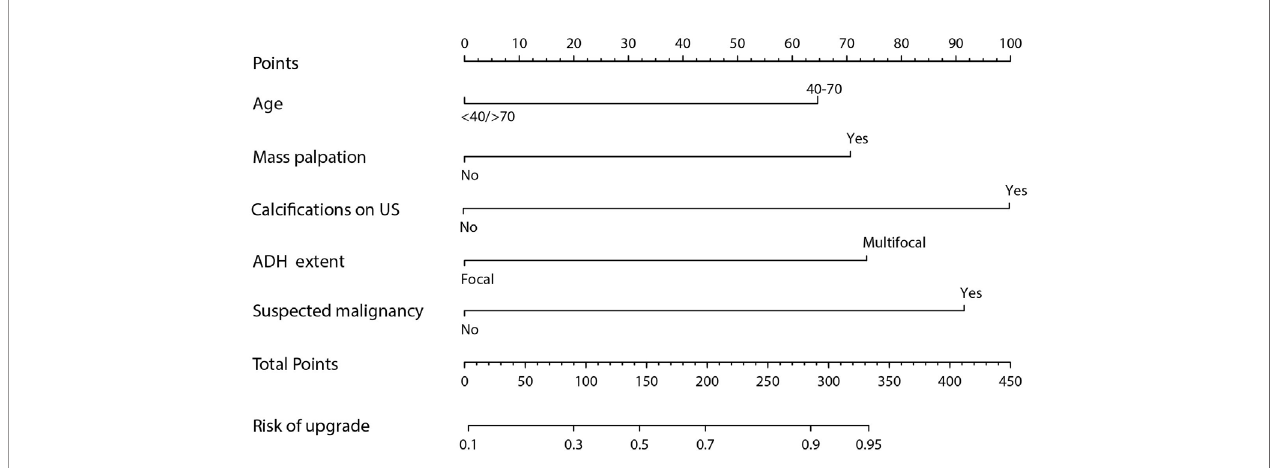
FIGURE 2 | Nomogram based on clinicopathological and US